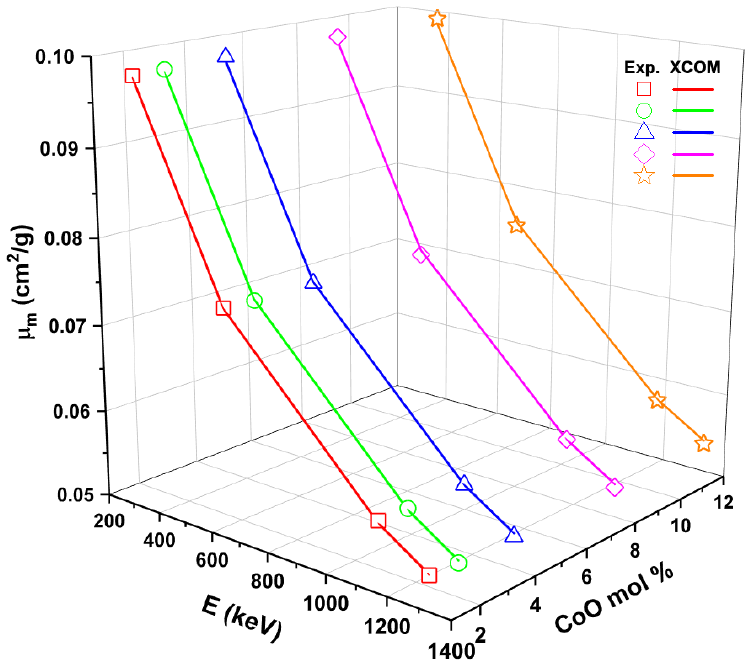
Figure 9. Experimental and theoretical mass attenuation coefficient (µ m ) against glass composition.